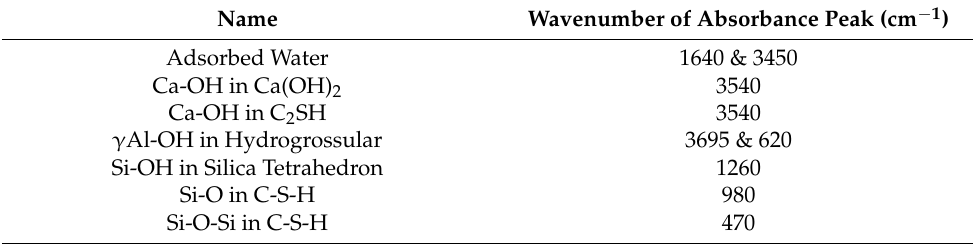
Table 6. Corresponding wavenumbers of typical